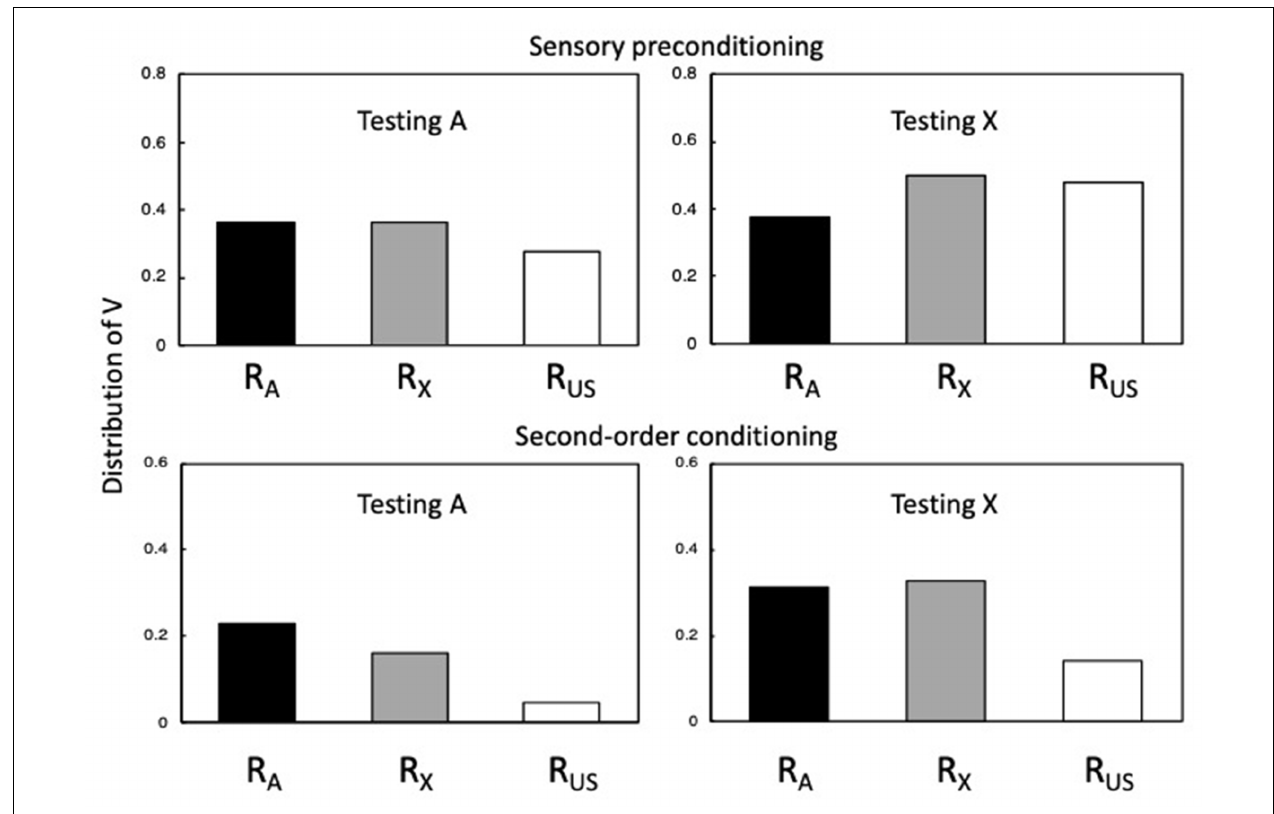
FIGURE 4 | Simulations of sensory preconditioning and second-order conditioning. The output values for R A , R X, and R US were generated for A and X using Equations 1–7 with α A = α X = β US = 0.80. There were 10 A → X trials and 2 X → US trials for the sensory preconditioning simulation, and 10 X → US trials and 2 A → X for the second-order conditioning simulation. For both simulations, the values of a R A , R X, and R US were then computed for A. Adapted from Honey and Dwyer (under